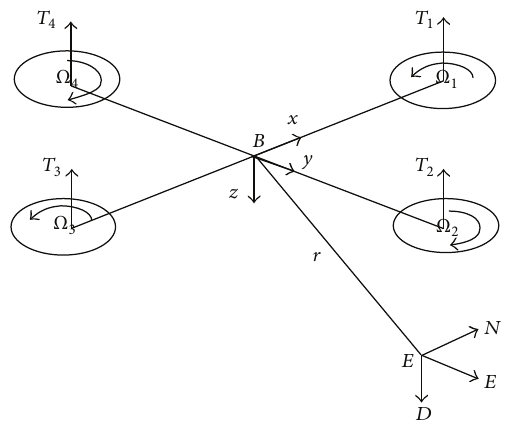
Figure 1: The structure of a quadrotor